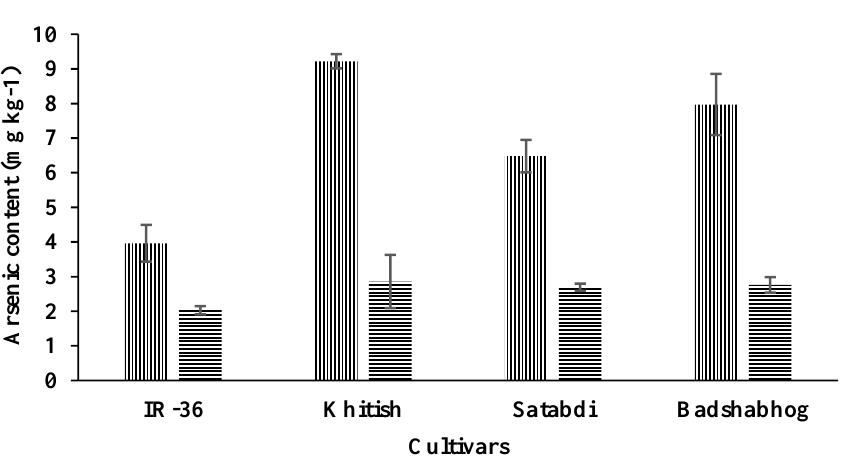
Figure 2. Arsenic content in the root and shoot of the different rice cultivars grown in Hoagland solution containing 100 μg L −1 As.